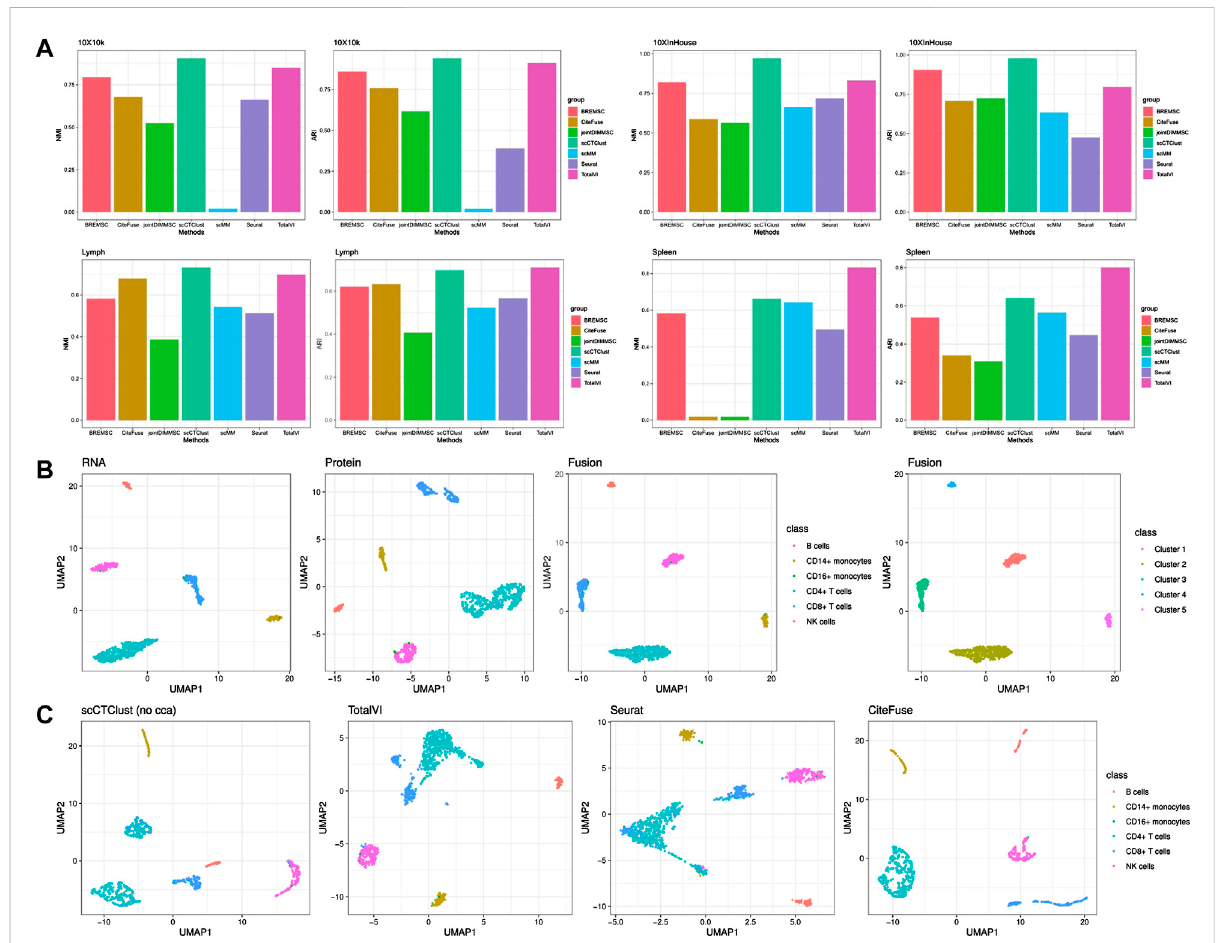
FIGURE 3 CITE-seq Experiments. (A) Performance of scCTClust and competing methods by NMI and ARI over real CITE-seq data sets 10X10 k, 10XInhouse,Lymph,andSpleen. (B) UMAPvisualizationofRNA,protein,andfusedfeaturesapplyingscCTClustoverthe10XInHousedataset;theleft three are colored by true cell types, and the right one is colored by the predictions. (C) UMAP visualization of latent features extracted by competing integrative methods, namely, scCTClust trained without CCA loss, TotalVI, Seurat, and CiteFuse, over the 10XInHouse data